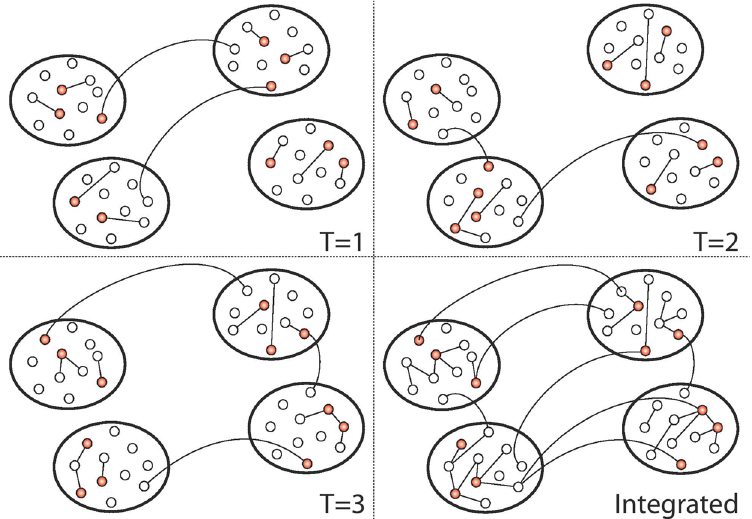
Figure 1. Schematic representation of the model. In red, we show active nodes. Straight lines and arcs describe links connecting nodes in the same or in different communities respectively. In the bottom right panel we show the integrated network obtained as the union of G 1 , G 2 , G 3